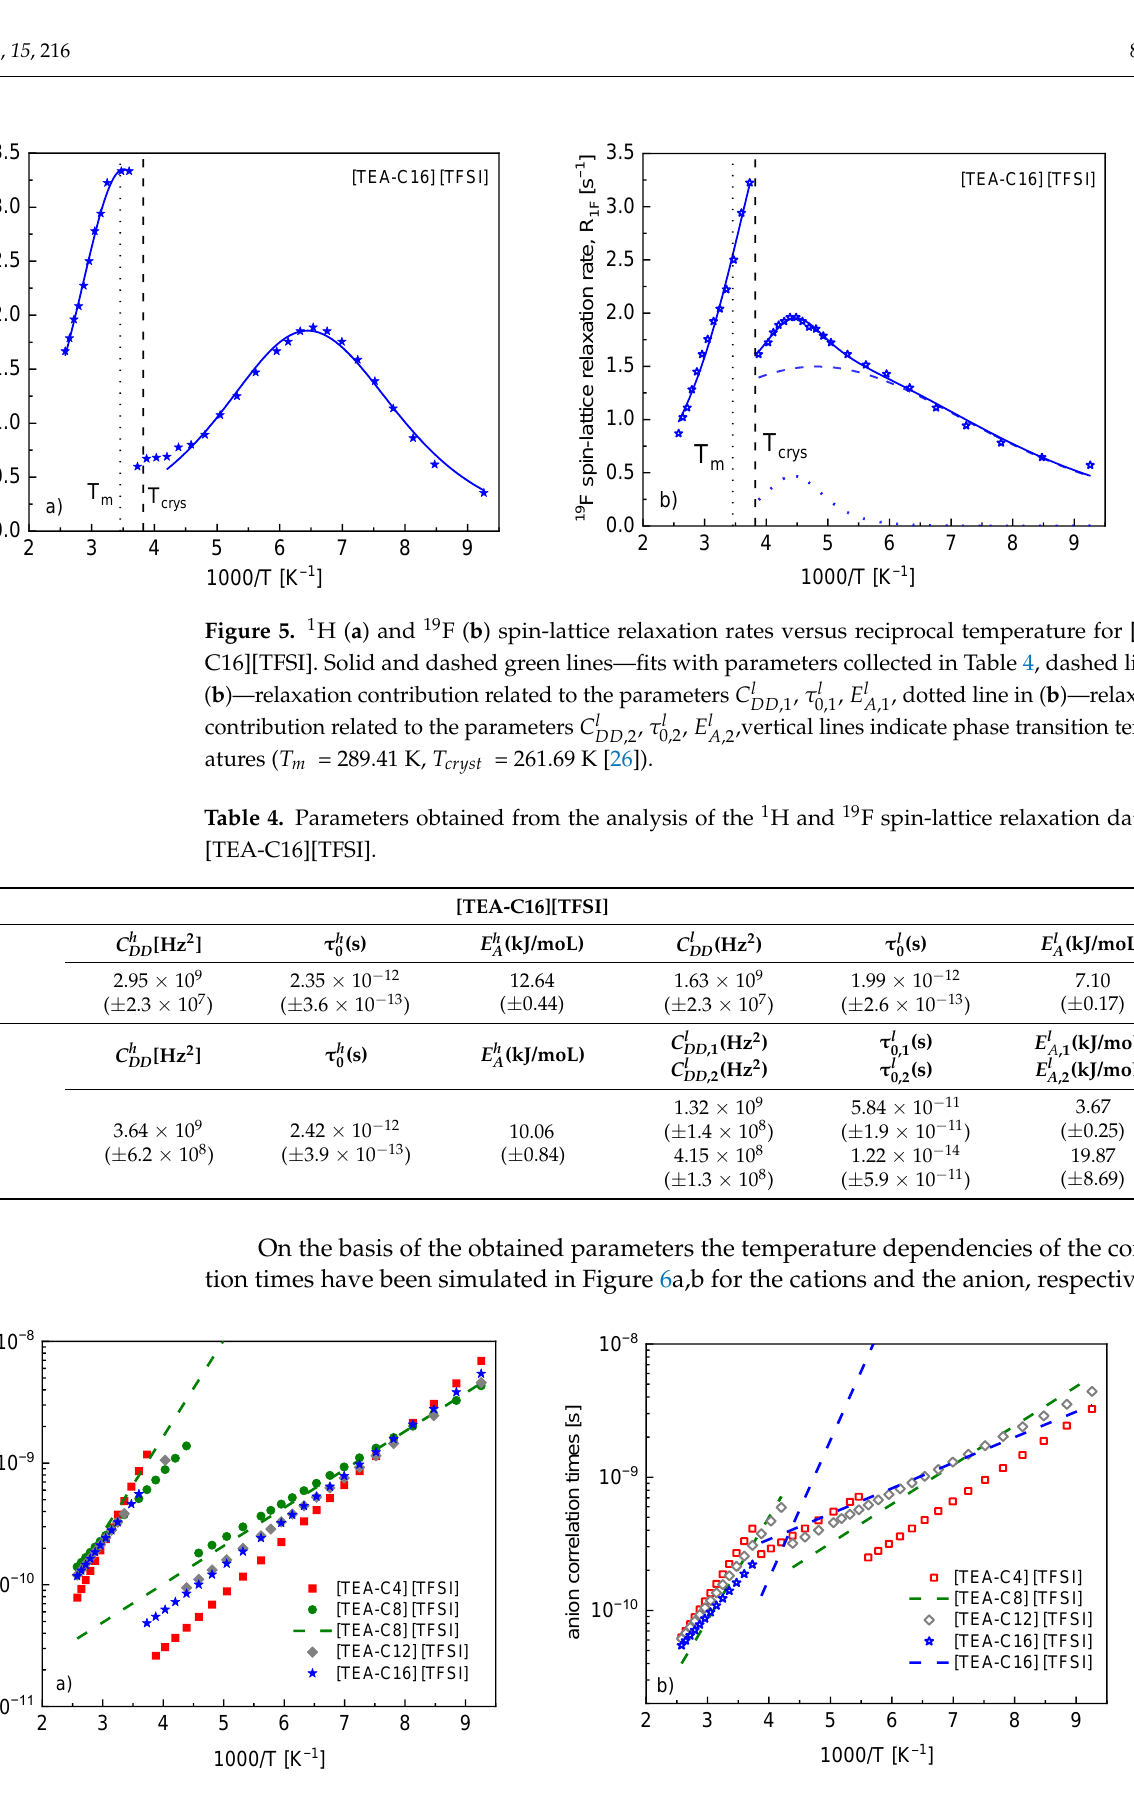
Figure 6. Correlation times for the cations ( a ) and the anion ( b ) versus reciprocal temperature; for ( a ): red squares — correlation times corresponding to the fit of Figure 2a, green circles — correlation times corresponding to the fit represented in Figure 3a as solid lines, dashed green lines — correla- tion times corresponding to the fit represented in Figure 3a as dashed line, grey diamonds — corre- lation times corresponding to the fit of Figure 4a, blue stars — correlation times corresponding to the fit of Figure 4a; for ( b ): red squares — correlation times corresponding to the fit represented in Figure 2b as solid lines, green dashed lines — correlation times corresponding to the fit of Figure 3b, grey diamonds — correlation times corresponding to the fit of Figure 4a, blue stars — correlation time cor- responding to the fit of Figure 4b below 𝑇 𝑐𝑟𝑦𝑠 , dashed blue lines — correlation times corresponding to the fit of Figure 4b above 𝑇 𝑐𝑟𝑦𝑠 . The results are discussed in the next section. 5. Discussion As already pointed out, the 1 H spin-lattice relaxation data for [TEA-C4][TFSI] show a discontinuity between the crystallization and melting temperatures. The two parts of the temperature dependence of the relaxation rate have been interpreted in terms of dy- namical processes following the Arrhenius law. The simulated temperature dependencies of the correlation times of [TEA-C4] cations at temperatures above and below the discon- tinuity are shown in Figure 6a (red points). Comparing the correlation time in the high temperature range with the rotational correlation time of [TEA-C4] cations in [TEA- C4][TFSI] [19] one sees that the last one is significantly longer — consequently, at 200 MHz one indeed probes the internal dynamics of the cation, not its rotation. Thus, one can sup- pose that the correlation time characterizes the motion of C 2 H 5 chains in the [TEA-C4] cation. Upon the phase transition the dynamics of the chains slows down, and the relaxa- tion becomes governed by the methyl group rotation at temperatures below the disconti- nuity. In principle, one can imagine a similar scenario for all the liquids — however, with some variations. For [TEA-C8][TFSI] one does not observe a discontinuity in the relaxa- tion curve. This effect is, however, misguiding. The analysis (solid lines in Figure 3b) shows that to reproduce the data two dynamical processes are required (that is obviously taking into account the presence of the two maxima of the relaxation rate) and the corre- sponding correlation times do not match each other (green points in Figure 6a) — there is a gap between them, in analogy to the case of [TEA-C4][TFSI]. The attempt to reproduce the data in a continuous manner (dashed line in Figure 3b) has led to a similar output in this sense that the two correlation times (dashed green lines in Figure 6b) do not differ much from those obtained from reproducing the relaxation maxima separately. It is worth noting that for [TEA-C12][TFSI] one sees a discontinuity in the relaxation rate, although